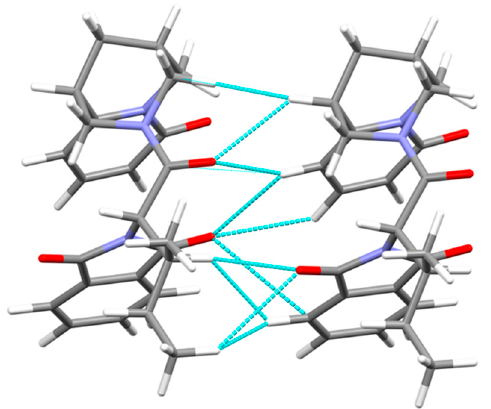
Figure 8. An example of a pair of molecules (related by unit translation along x-direction) and connected by weak, numerous interactions, giving rise to relatively high interaction energy: E int : − 44.2 kJ/mol (B3LYP); − 43.3 kJ/mol (PIXEL). Table 5. The details of the interactions for the pair of the highest interaction energy in 2 ( i 1+x, y, z: 10 contacts with critical points). Upper part: geometrical details; lower: topological; D12: distance between two atoms; Gcp: kinetic energy density (kJ/mol/Bohr3); Vcp: potential energy density (kJ/mol/Bohr 3 ); Dcp1, Dcp2: distance from the first and the second atom to the critical point, re- spectively; Lap: laplacian (cid:4670)(cid:1487) (cid:2870) (cid:3435)ρ (cid:2912)(cid:2913)(cid:2926) (cid:3439) (eÅ –5 )]; Den: electron density (cid:4670)ρ (cid:2912)(cid:2913)(cid:2926) (eÅ –3 )]. D